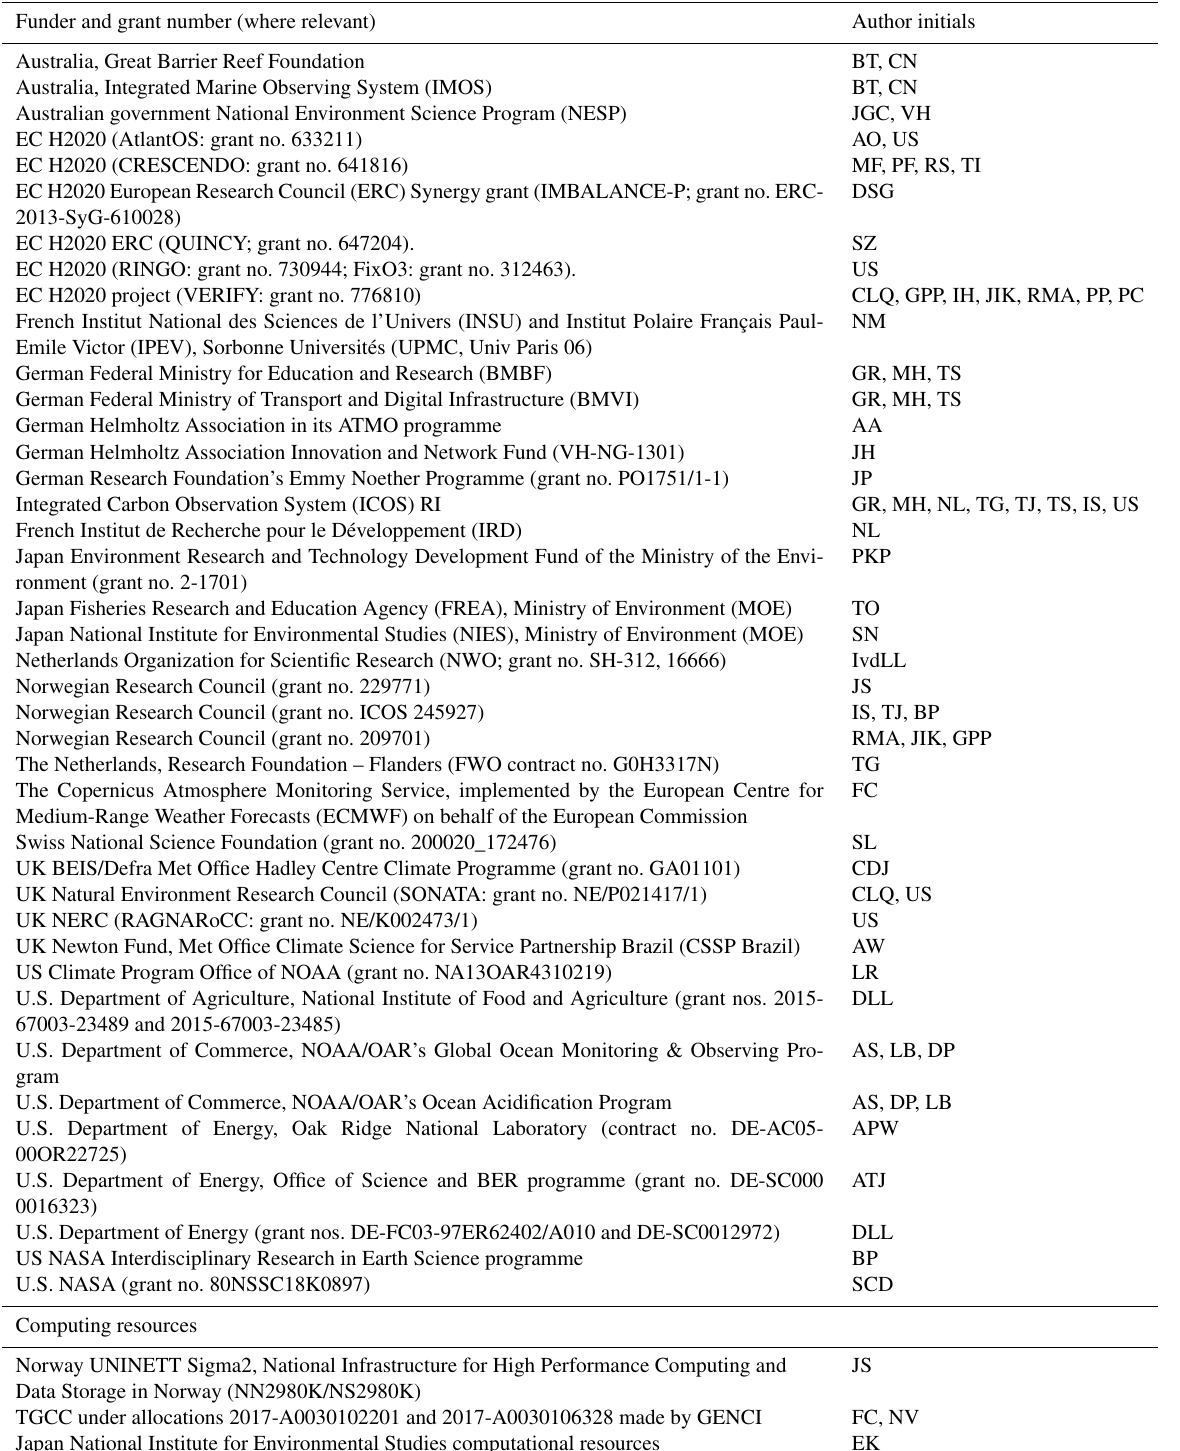
Table A5. Funding supporting the production of the various components of the global carbon budget in addition to the authors’ supporting institutions (see also